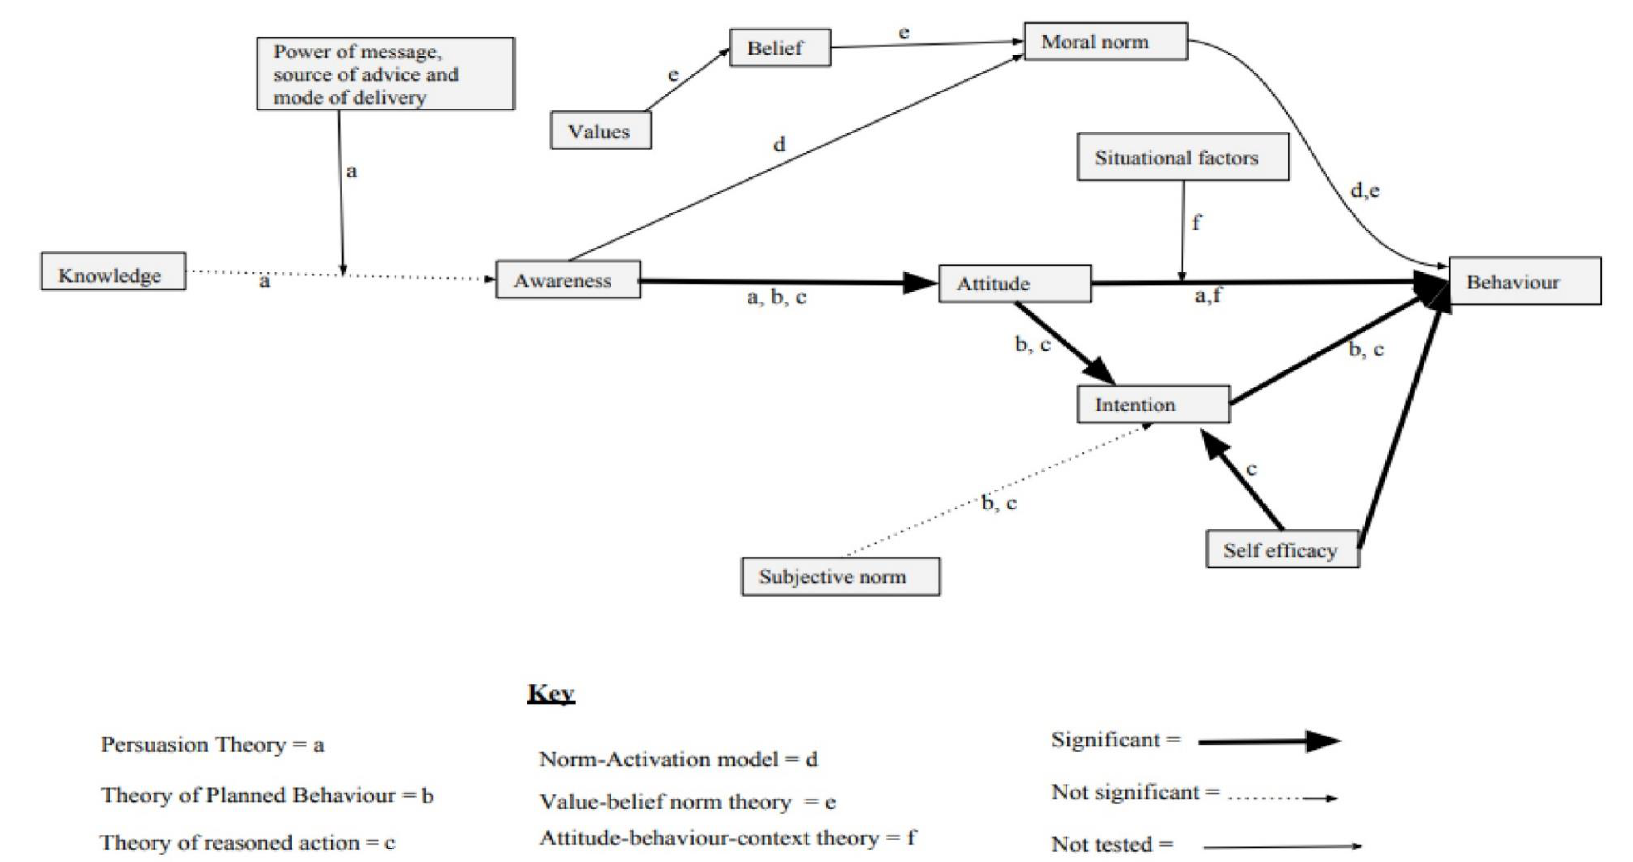
Figure 4. Integrated Framework of paths tested under the di ff erent theories. Note: We use letters to represent the di ff erent pathways (e.g., knowledge-awareness link, awareness-behaviour link, knowledge-behaviour link) hypothesised in each of the theories.